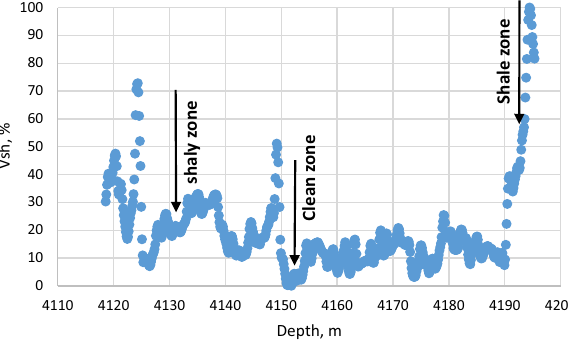
Fig. 12 Shale, shaly and clean zones within the Lockhart Limestone of Meyal-10P, Meyal Oil Field